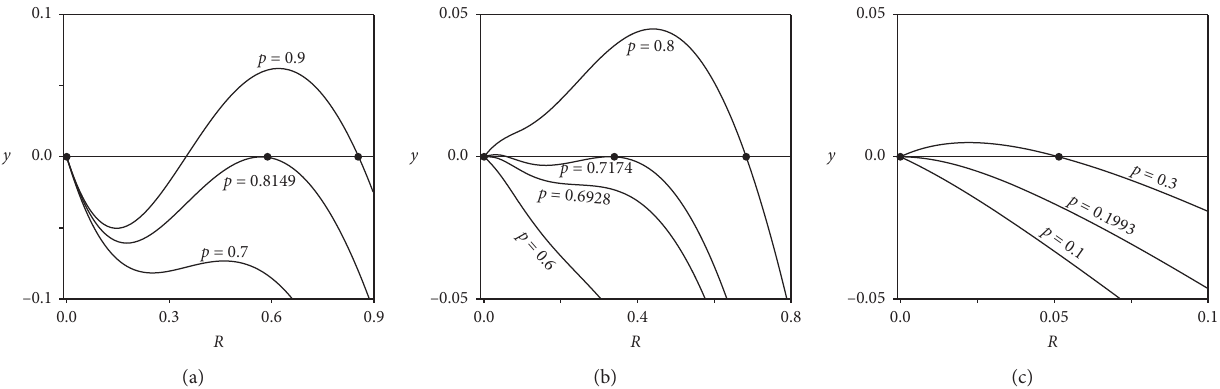
Figure 2: The graphical solutions of equation (1) for different values of p and α , as marked by the black dots. (a) The result for α � 0 . 5, (b) the result for α � 0 . 65, and (c) the result for α � 0 . 9. For each panel, the degree distribution of networks follows a truncated power-law ) , where k � 2, k � 141, and c � 2 . distribution p k ∼ k − c ( k ≤ k ≤ k min max min max